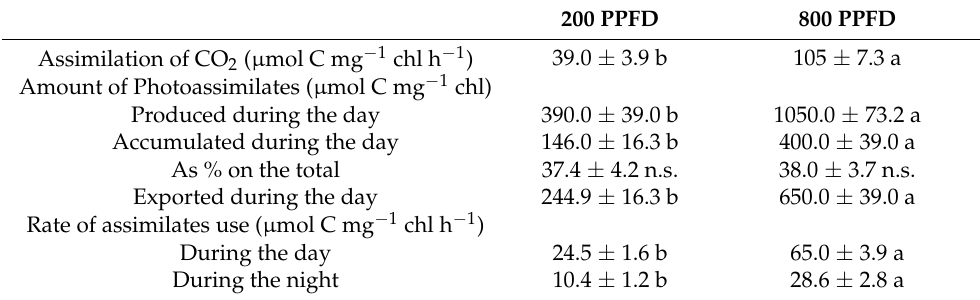
Table 4. Estimated amount and export rates of assimilates in spinach leaves grown in a growth Table 3. Assimilates exported during the day were calculated as the difference between the rate of photosynthesis and the carbon amount accumulated as total carbohydrates during the light period of 10 h (values shown in Table 3). Mean values ± S.E. (n = 12). Different letters indicate significant differences at p = 0.05 (Fisher’s post-hoc test), n.s.—not significant. 200 PPFD 800 PPFD Assimilation of CO 2 ( µ mol C mg − 1 chl h − 1 )